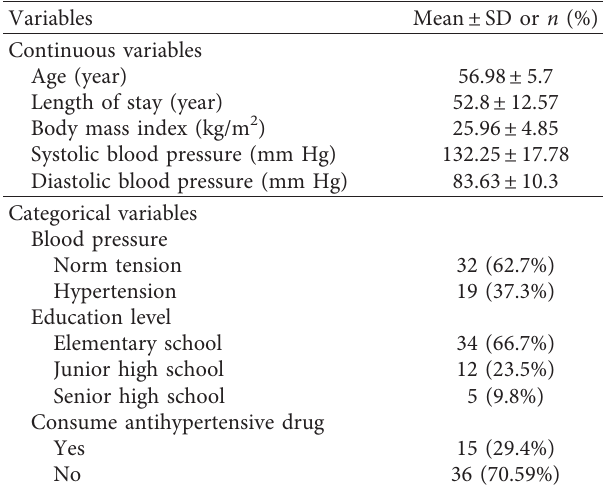
Table 2: Demographic variables of the 51 subjects who participated in the study.